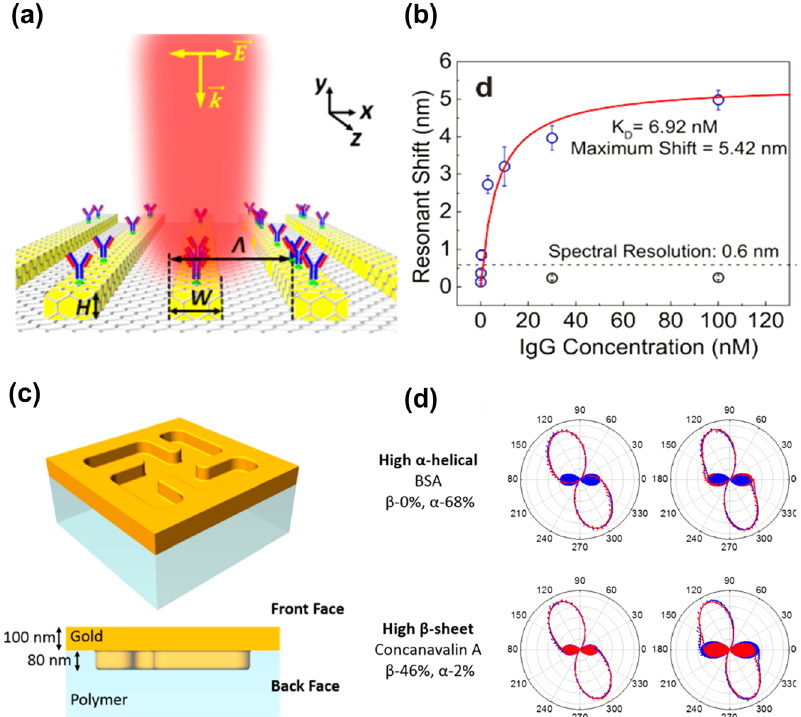
Figure 5: Antibodies and protein